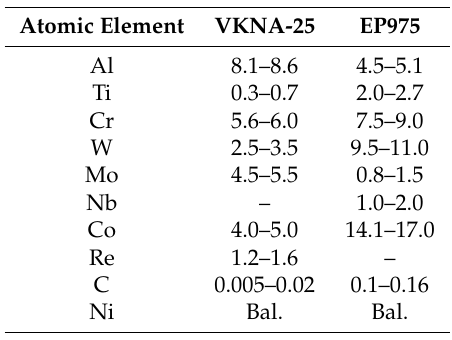
Table 1. Chemical composition of VKNA-25 and EP975 alloys in weight percent [40].